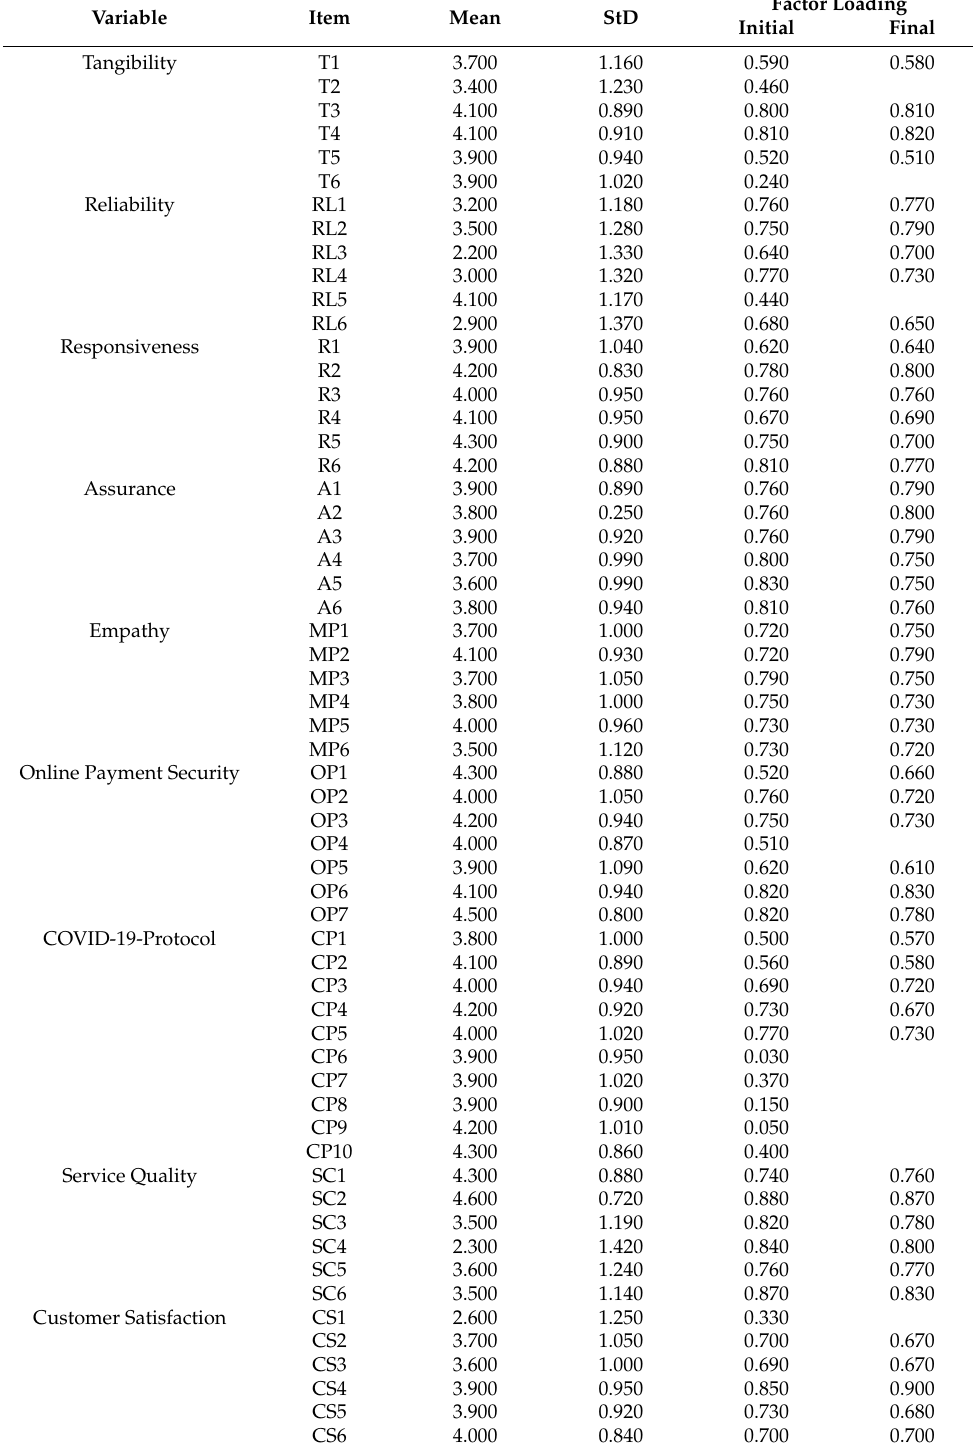
Table 3. Descriptive statistics